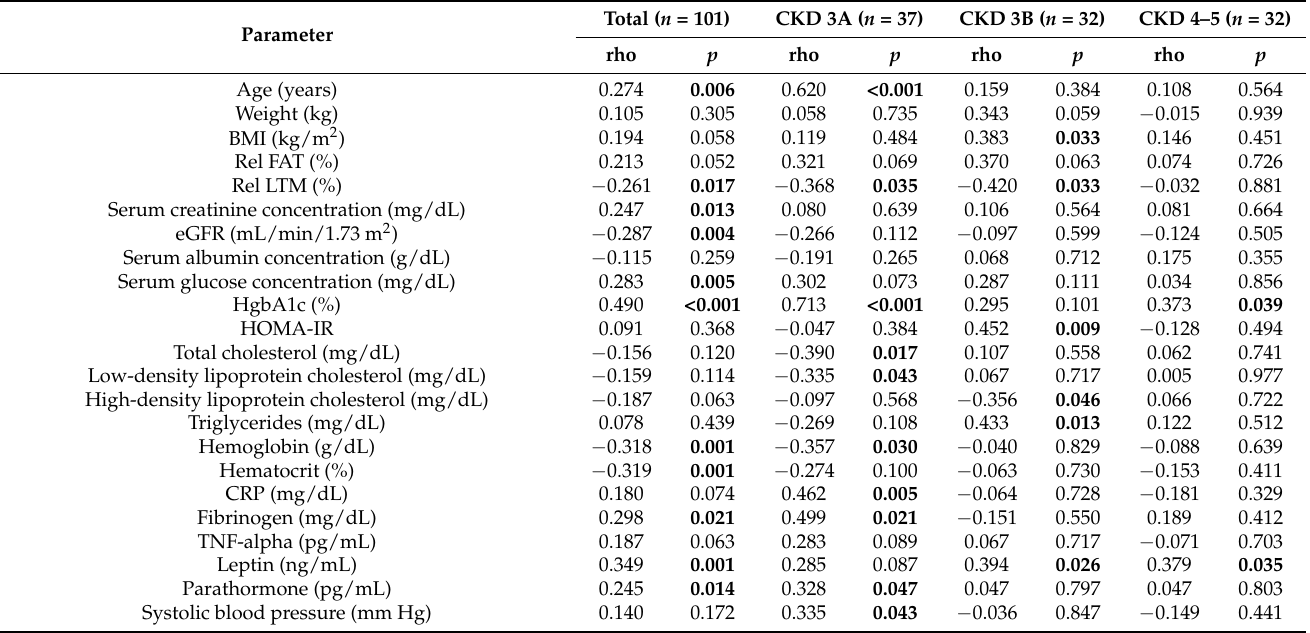
Table 2. Sclerostin correlations with clinical and biochemical parameters.